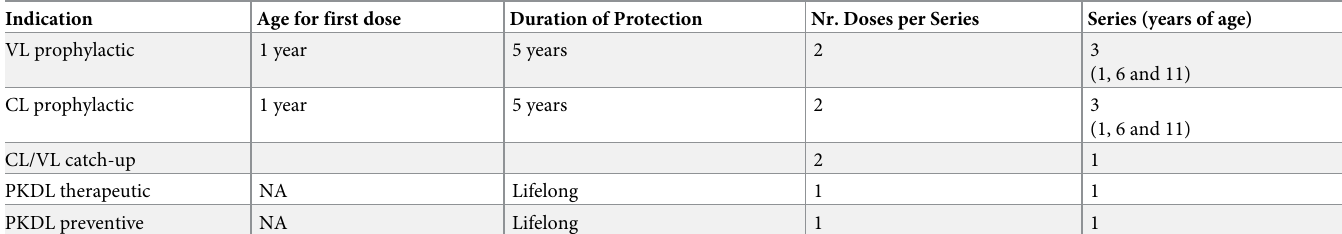
Table 1. Selected TPP assumptions relevant for the demand forecast.